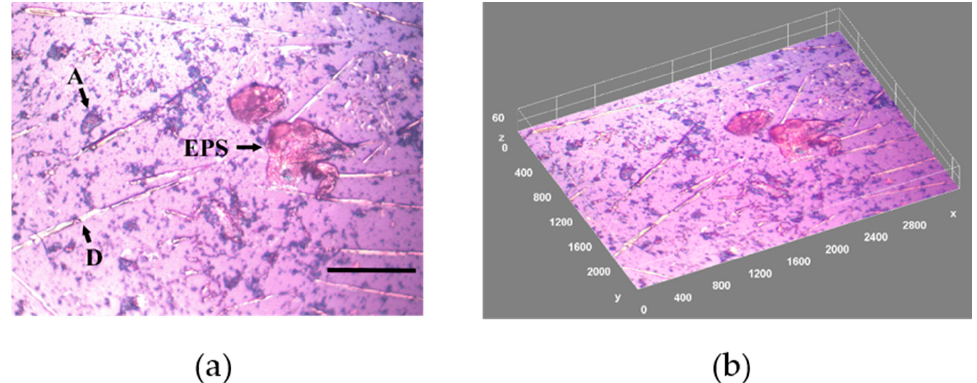
Figure 2. ( a ) A microscopic reflected image from the EPS stained with KMnO 4 (brown areas) biofilm sample grown on glass slides (3-day old) in natural seawater (Baltic Sea, Gulf of Gda´nsk, Poland) collected in August 2018. Black arrows point to the reflective biofilm structures: EPS comprising areas, silica frustules of diatoms (D), and amorphous inorganic material (A). Marker bar = 10 µ m, distance scale 34 pixels = 10 µ m. ( b ) 3D reconstructed image from ( a ). Morphological structure parameters: total surface coverage f = 4.8%, mean thickness = 14 µ m, roughness fluctuation coefficient = 0.132, biovolume = 17,500 µ m 3 , fractal dimension = 1.27, Hopkin’s aggregation index = 2.33, AC = 0.15, diatom abundance = 2.6 × 10 4 ind. cm − 2